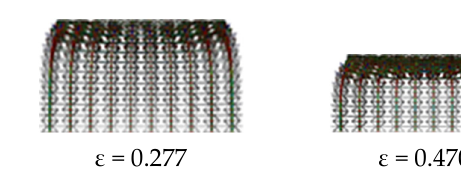
Figure 8. Deformation of specimen at medium speed (20 m/s and α = 45°).